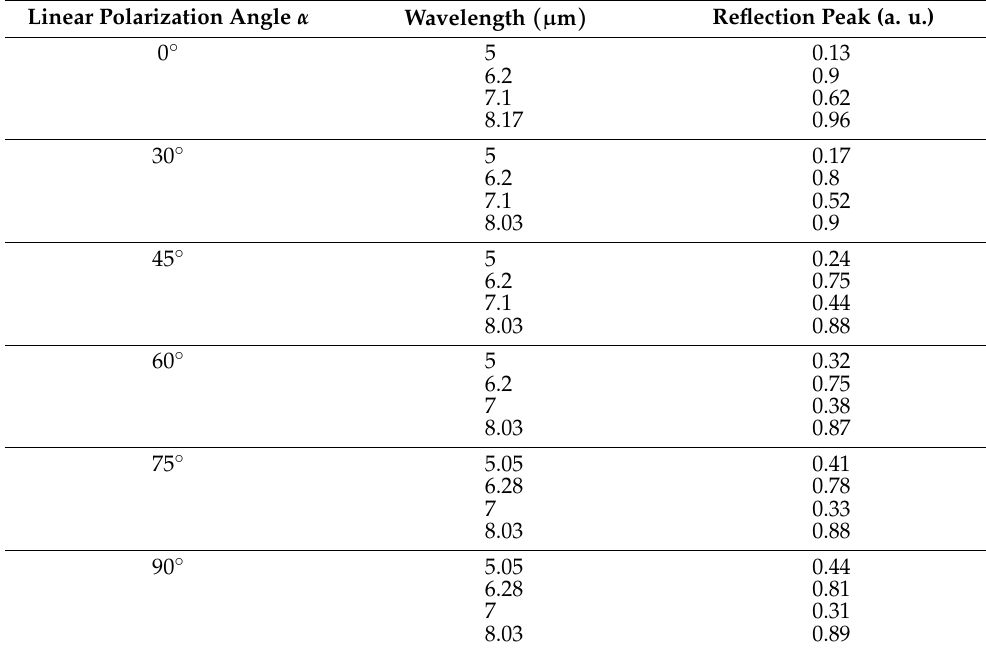
Table 3. Peak values associated with the reflection spectrum of structure 2C, at linear polarization angles α = 0 ◦ , α = 30 ◦ , α = 45 ◦ , α = 60 ◦ , α = 75 ◦ and α = 90 ◦ . These frequencies correspond to frequencies of minimal absorption.